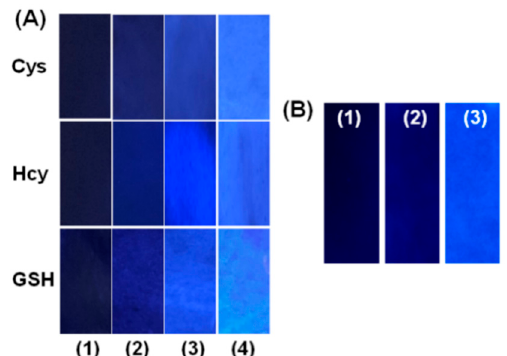
Figure 7. ( A ) Photographs of fluorescence colour responses of the L -Cu 2+ -coated test papers immersed to different concentration of Cys, Hcy and GSH in water under 365 nm UV light: (1) 0 mM, (2) 0.05 mM, (3) 0.5 mM, (4) 5 mM. ( B ) Photographs of the fluorescence colour responses in human urine sample: (1) L -Cu 2+ -coated test paper only, (2) Free filter paper exposed to pure urine, (3) L -Cu 2+ -coated test paper when immersed to human urine under 365 nm UV light. All the filter paper